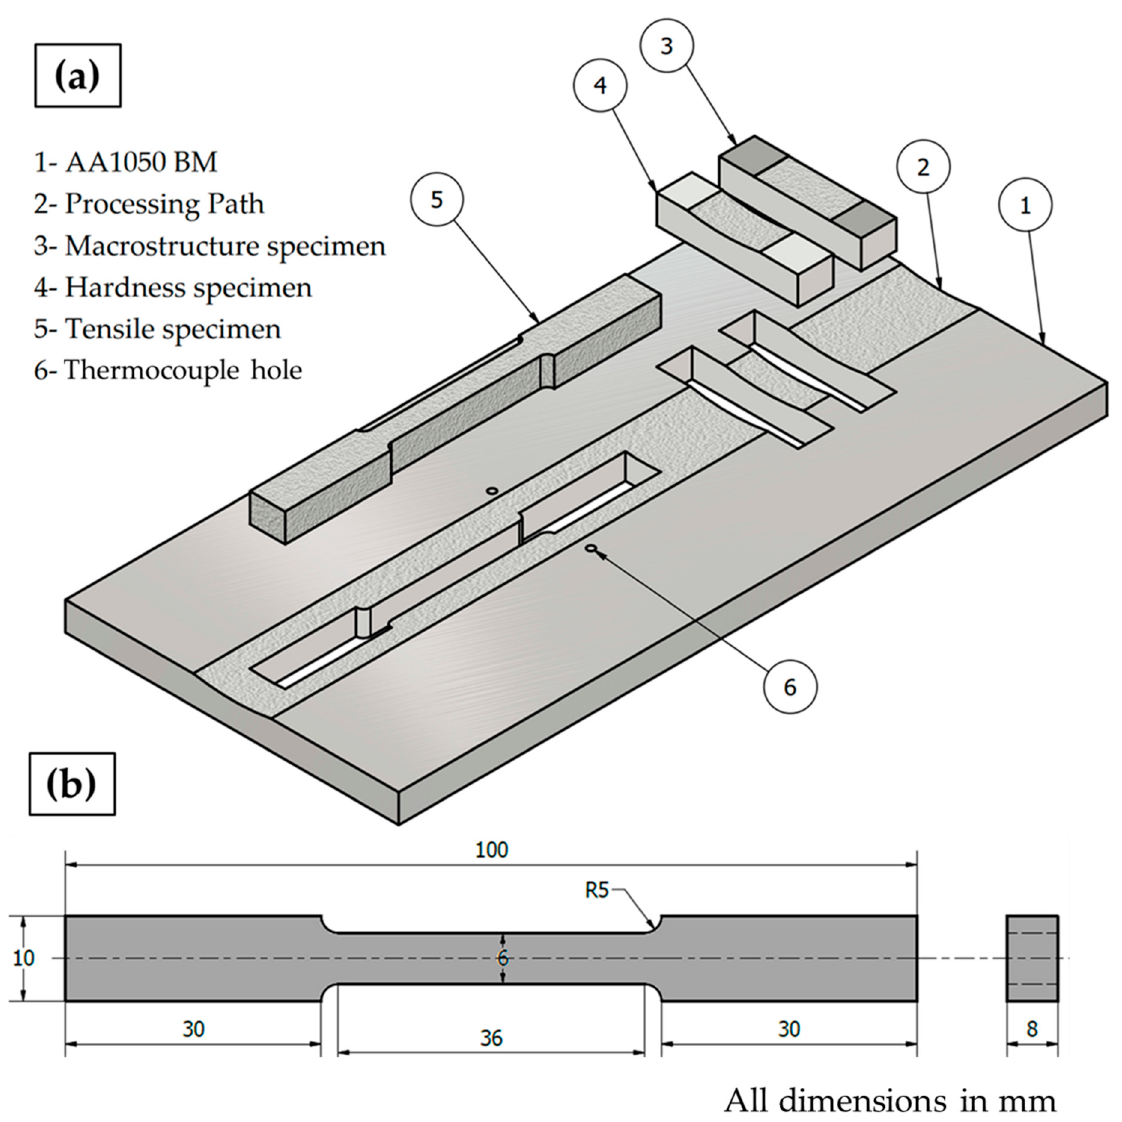
Figure 4. Schematic drawing shows ( a ) the location of cutting test specimens for the processed materials and ( b ) the dimensions of tensile test specimens (thermocouple in Figure 4). To evaluate the hardness of the BT-FSPed AA1050, the cross-section of the processed materials is divided into five lines to present three layers: upper layer (L1), middle layer (L2), and lower layer (L3), as shown in Figure 5. Hardness were measured at all layers on the polished cross-sections by a hardness tester machine (HWDV-75, TTS Unlimited, Osaka, Japan) with a load of 0.3 kg and a dwell time of 15 s. The measurements were repeated for three specimens at each condition and plotted in terms of hardness contour map and average